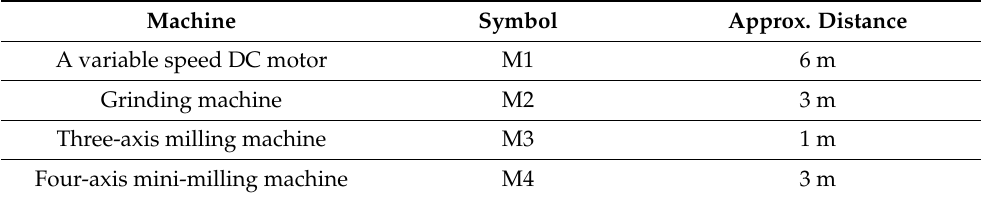
Table 2. Background machine distance measures.